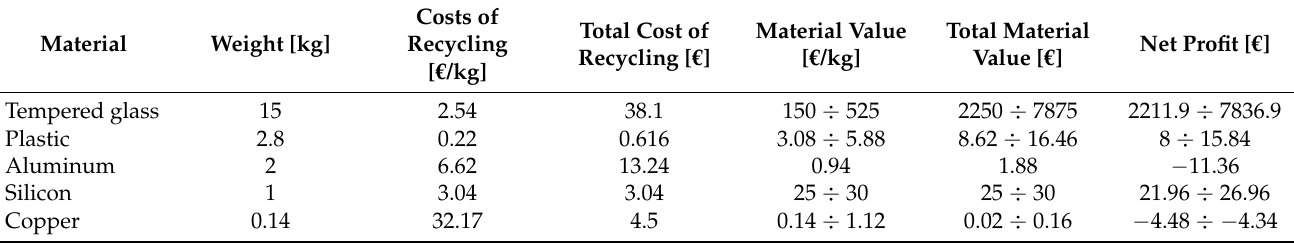
Table 3. Cost of recycling, material value and net profit.